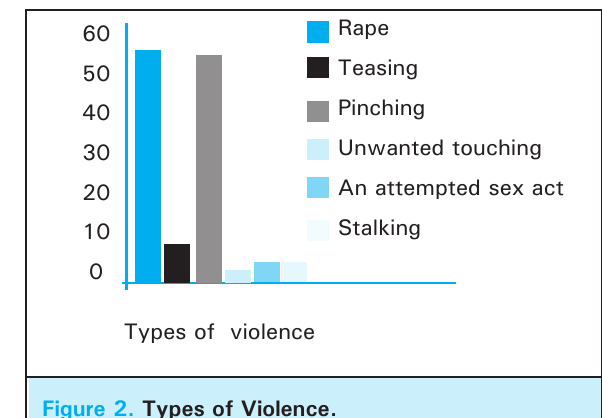
Figure 2. Types of Violence.